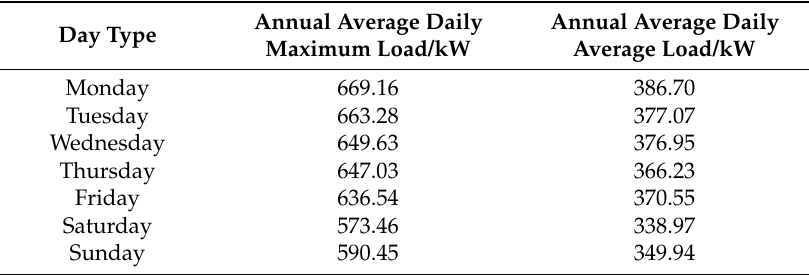
Table 1. Load characteristics of different day